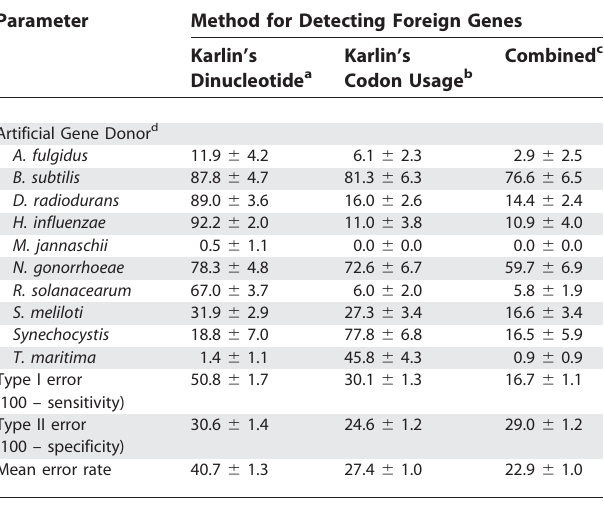
Table 3. Performance of Combined Parametric Methods for Detecting Atypical Genes in Prokaryotic Genomes Parameter Method for Detecting Foreign